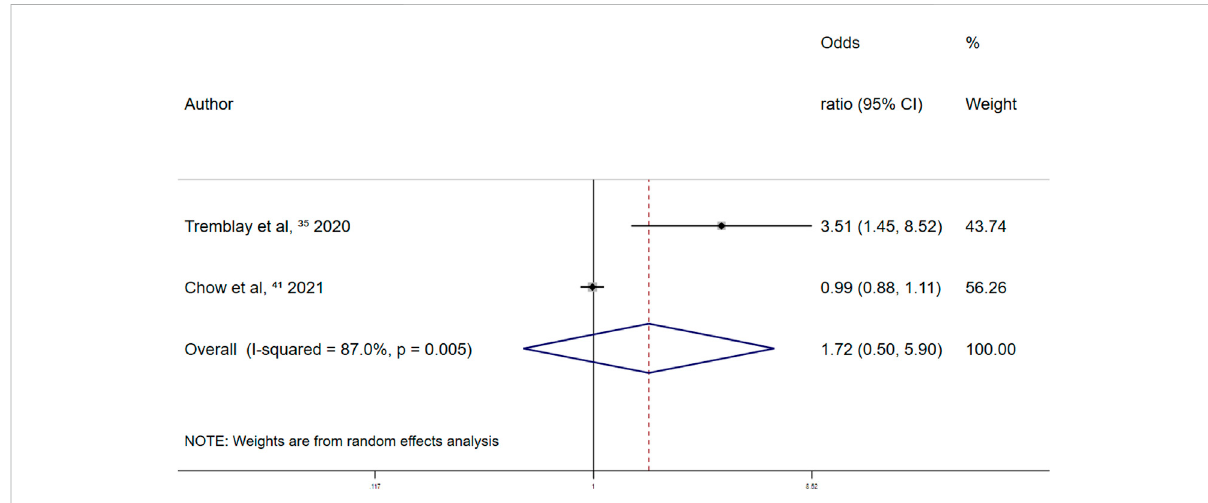
FIGURE 9 Summary odds ratio of bleeding events for other antiplatelet drugs use in retrospective studies.